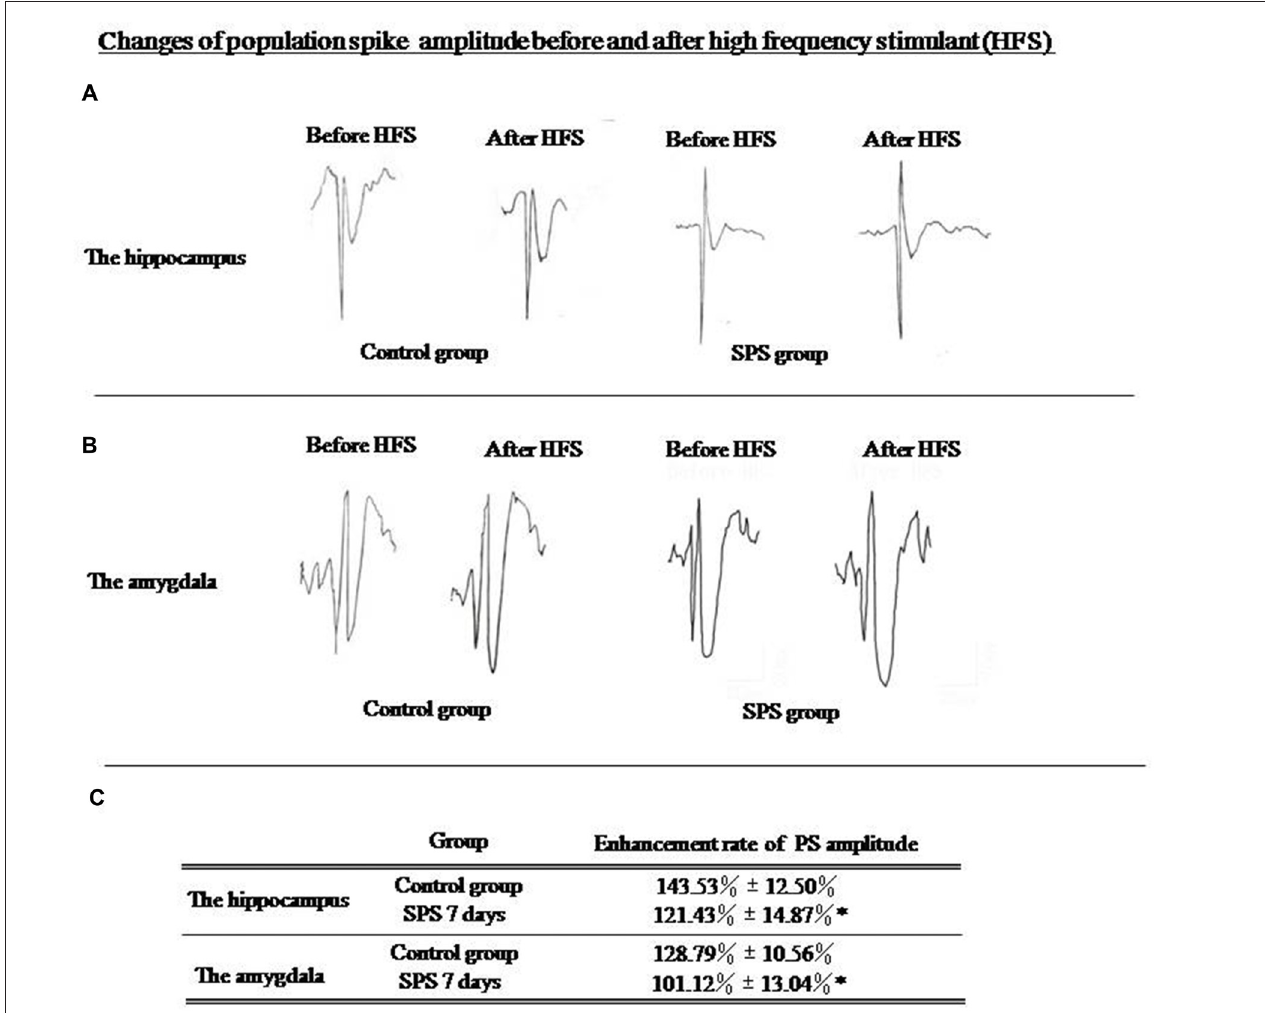
FIGURE 2 | (A) Evoked population spike (PS) wave formed before and after high frequency stimulation (HFS) in hippocampus; (B) Evoked PS wave formed before and after high frequency stimulation (HFS) in amygdala. (C) SPS rats showed significantly decreased enhancement of evoked PS amplitude in hippocampus and amygdala compared with control rats ( ∗ P < 0.05 vs. the control